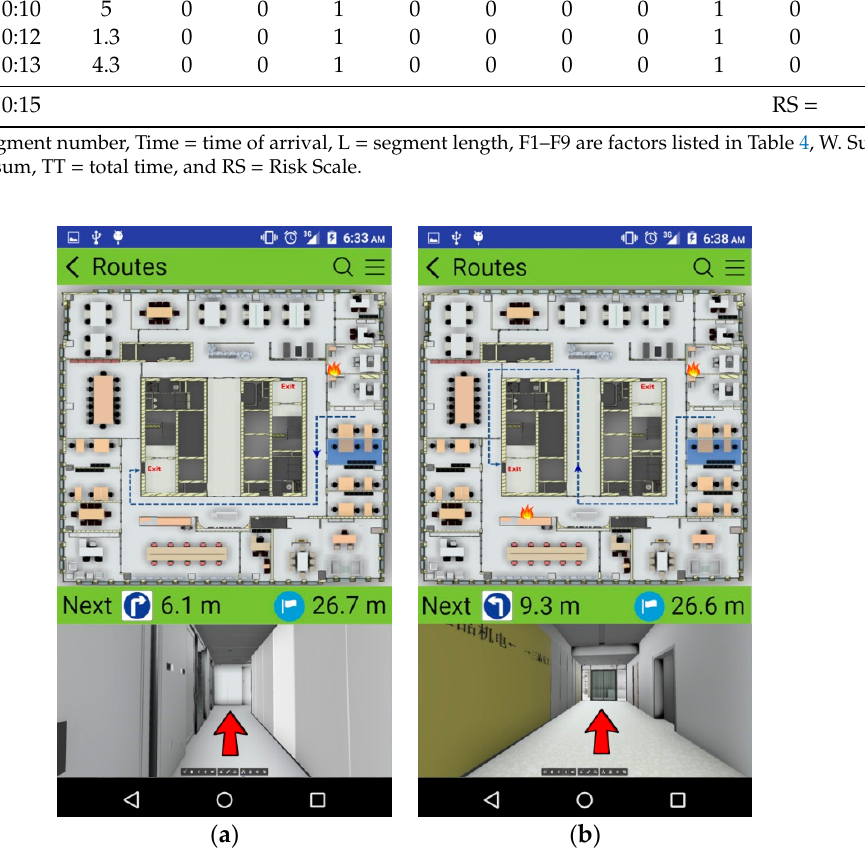
Figure 8. Smartphone display in ( a ) Scenario 1 and ( b ) Scenario 2.